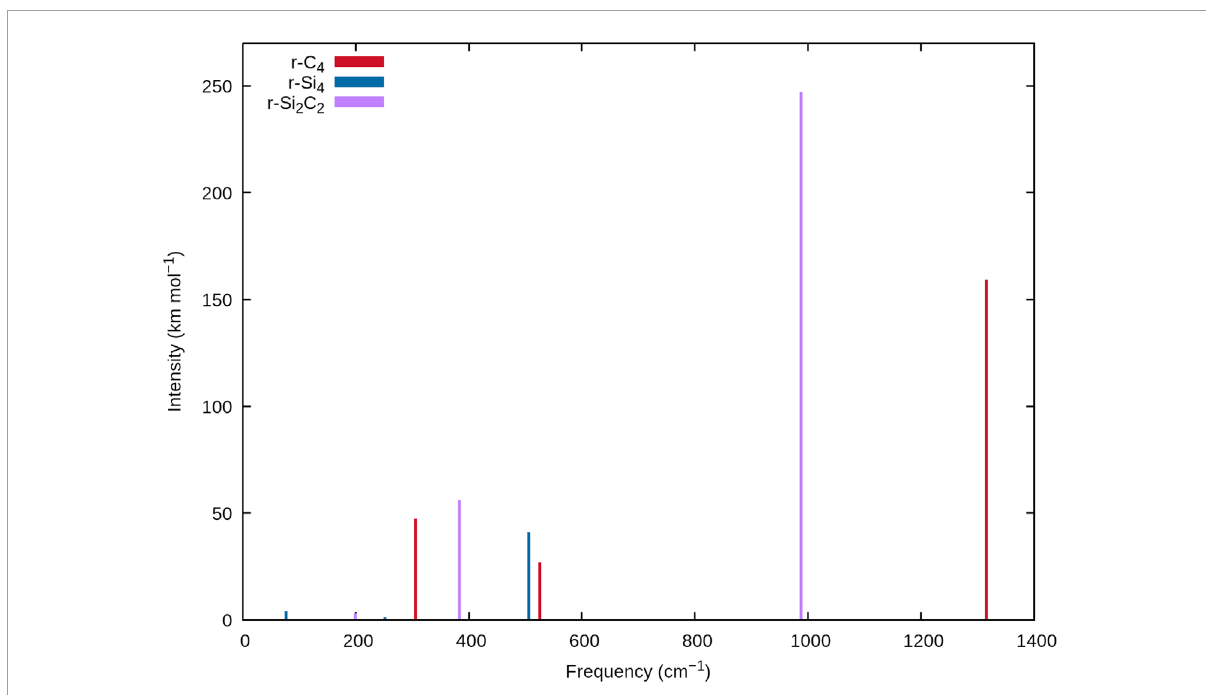
FIGURE 2 Stick spectra of r -C 4 , r -Si 4 , and r -Si 2 C 2 at the F12-TZ-cCR level of theory showing the decreasing frequencies with Si